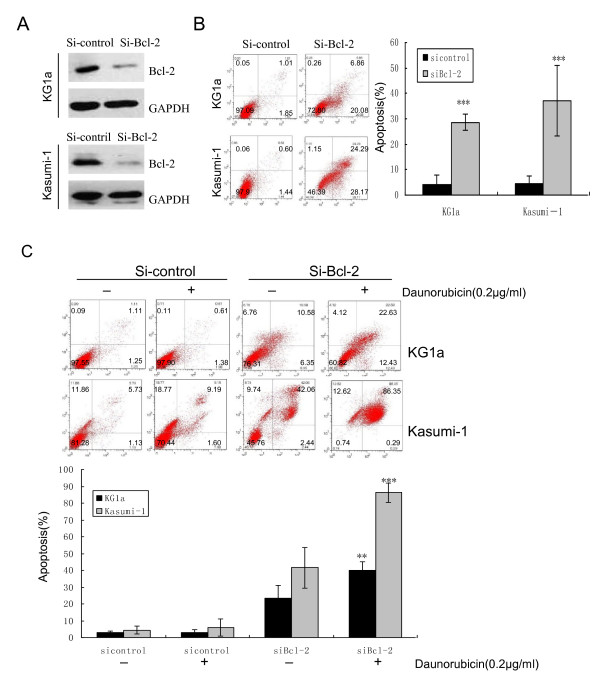
Suppression of Bcl-2 with siRNA induced apoptosis and increased susceptibility to DNR. KG1a and Kasumi-1cells were transfected with siRNA Bcl-2 or siRNA control for 24 h. (A) Bcl-2 protein levels were determined by Western blotting assay. (B) Cells were stained with Annexin V/PI to analyze apoptotic cell populations. The graph displays the means ± SD of three independent experiments. (C) KG1a and Kasumi-1 cells were transfected with siRNA Bcl-2 or siRNA control for 24 h, and then treated with DNR (0.2 μg/ml) for 48 h. Cells were stained with Annexin V/PI to analyze apoptotic cell populations. The bar represents mean ± SD of three independent experiments. ** p < 0.01, *** p < 0.001 (compared with control).